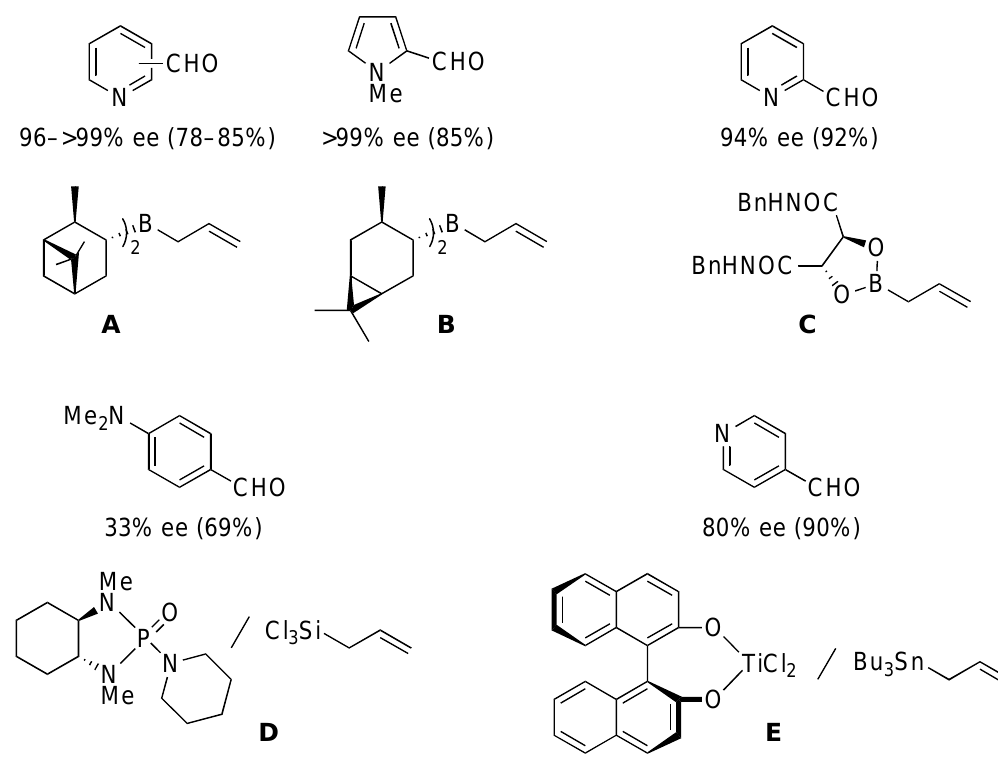
Figure 1. Chiral allylmetal reagents for the asymmetric allylation of amino